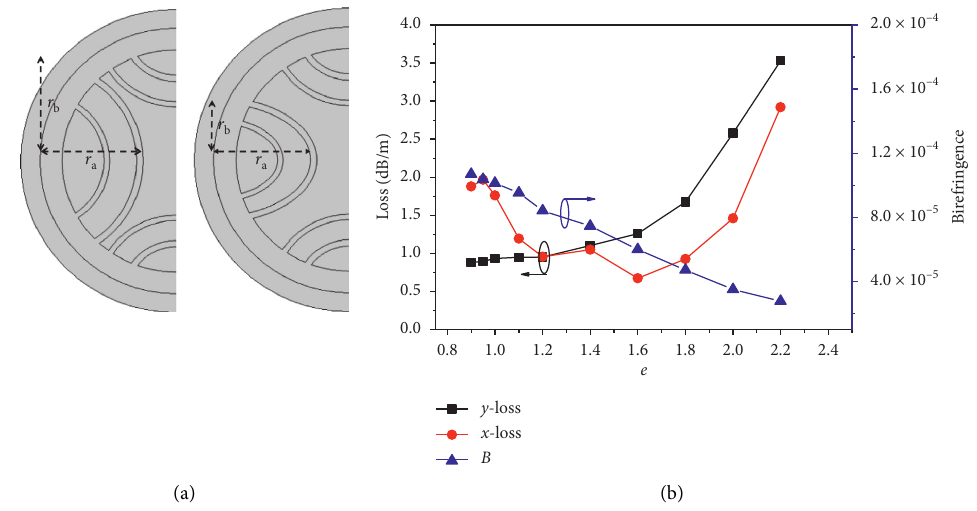
Figure 8: (a) Diagram of e change. (b) x and y polarization mode loss and birefringence as a function of e .